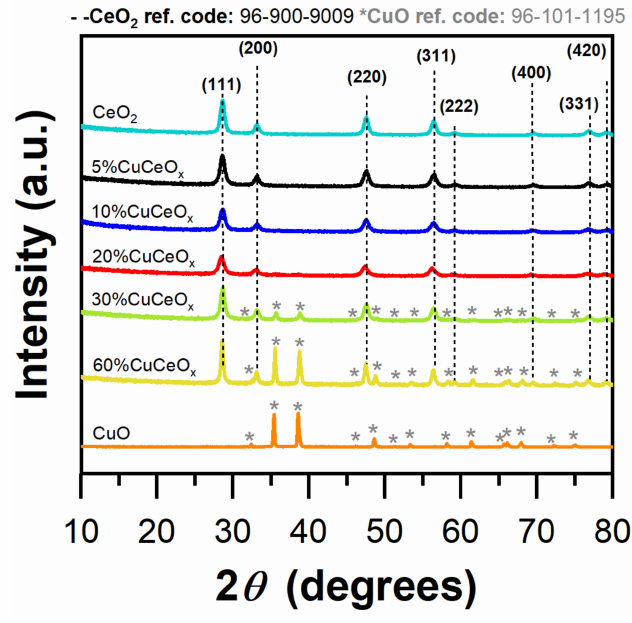
Figure 1. X-ray diffractograms in the range 10 ◦ < 2 θ < 80 ◦ over the samples. The typical peaks of CuO are marked with asterisks.